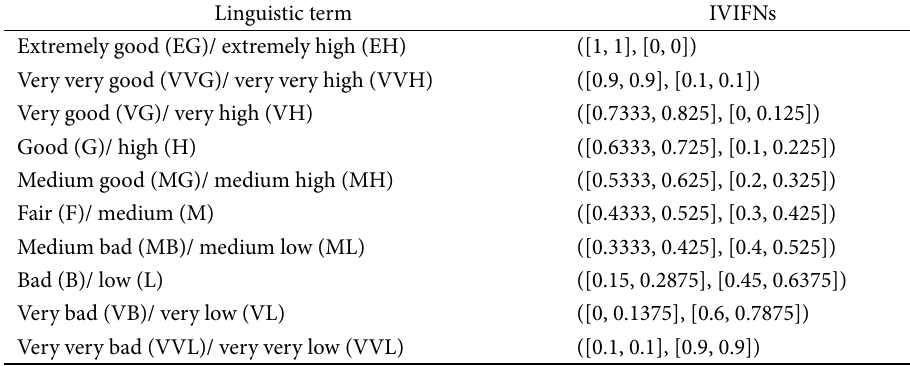
Table 2. The iviFN scale to rate alternatives to criteria